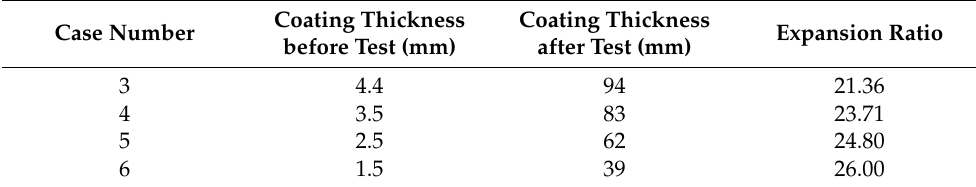
Table 7. Thickness statistics of IFC before and after the